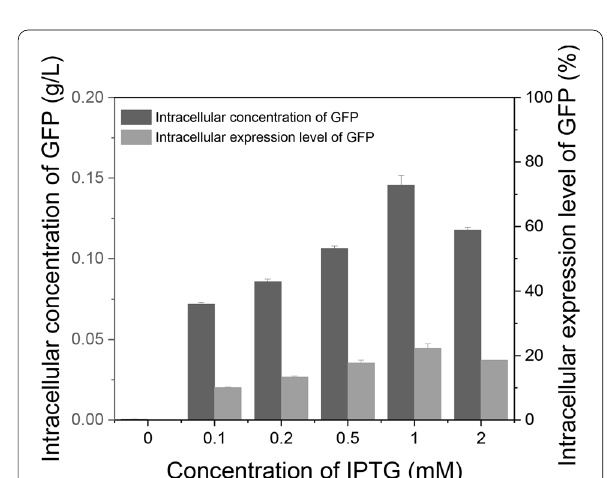
Fig. 4 Effects of the inducer IPTG concentration on GFP expression level and total GFP